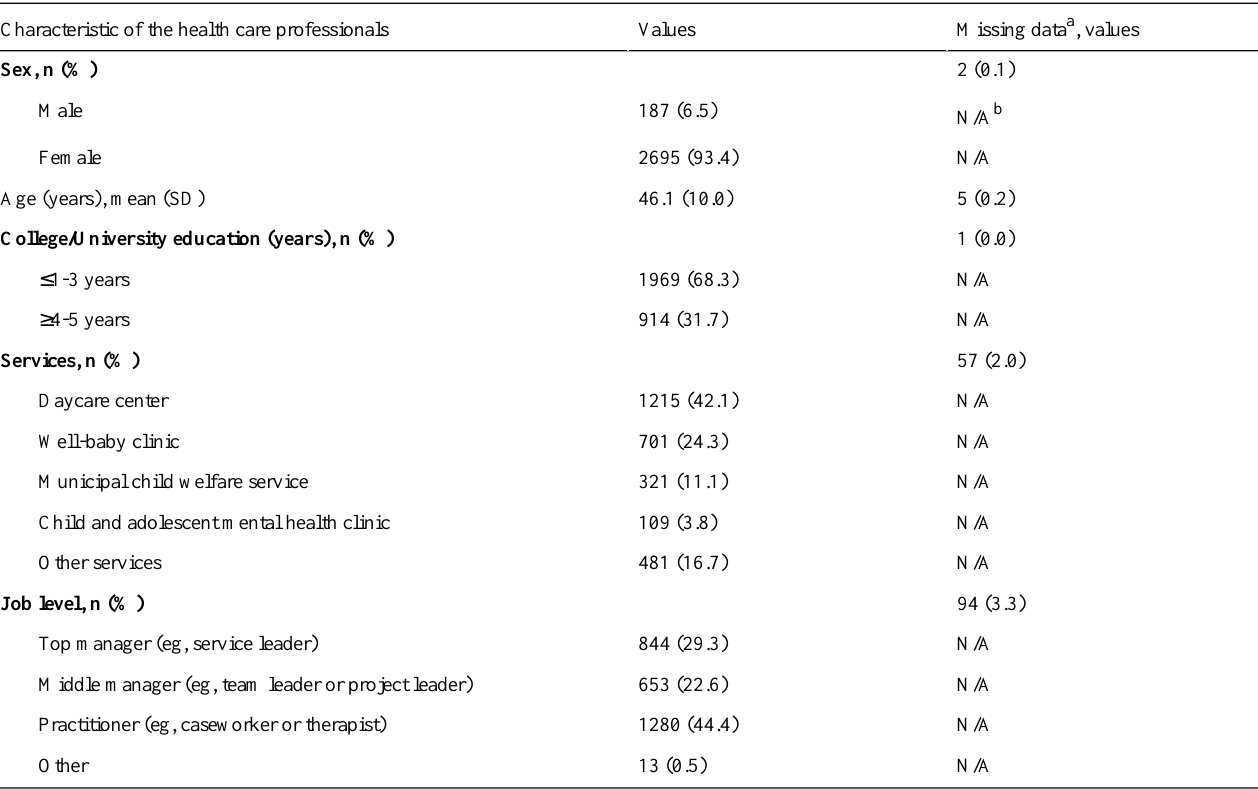
Table 1. Characteristics of the infant and child health leader and practitioner population in this study (N=2884).